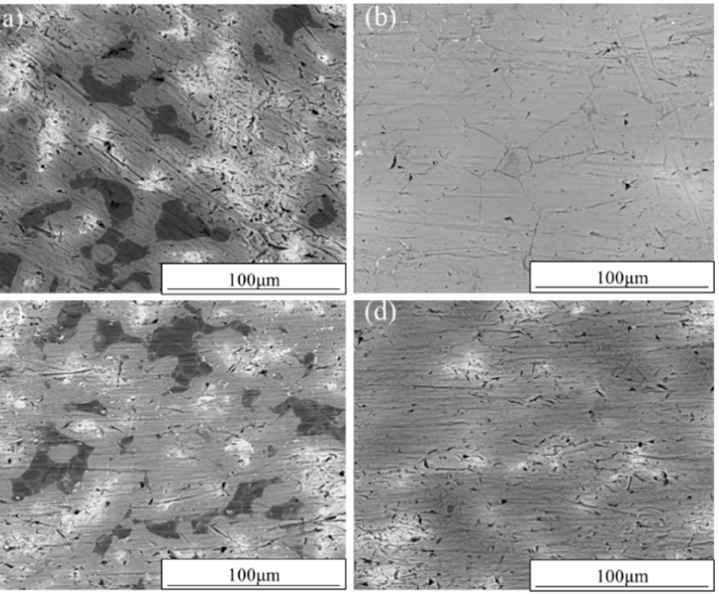
Figure 4. The SEM morphologies of Ti-40Nb-10Ag alloy for different sintering temperature. ( a ) 950 °C Ti-40Nb-10Ag; ( b ) 975 °C Ti-40Nb-10Ag; ( c ) 1000 °C Ti-40Nb-10Ag; ( d ) 950 °C Ti-40Nb.